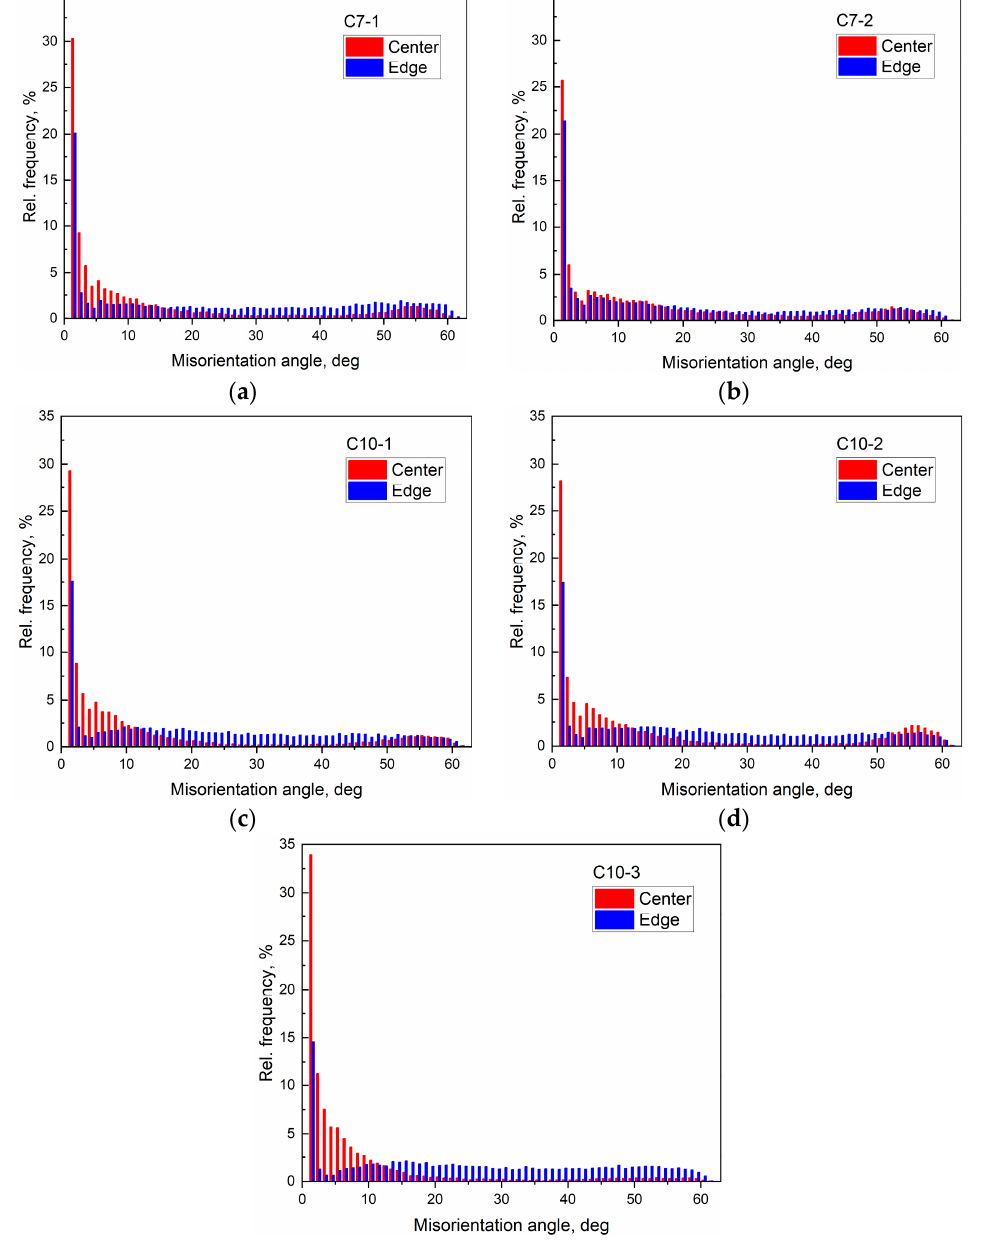
Figure 11. Histograms of grain-boundary misorientation-angle distribution in the region of the center and edge of samples ( a ) C7-1 (near the C7 wire fracture region), ( b ) C7-2 (far from the fracture region), ( c ) C10-1 (from the region of the C10 wire near the 1st clamp), ( d ) C10-2 (from the region of the center of the C10 wire), and ( e ) C10-3 (from the region of the C10 wire near the 2nd clamp). For better visualization, the histograms are shifted along the abscissa axis by the width of the base of the histogram columns to the left and right relative to the true position.